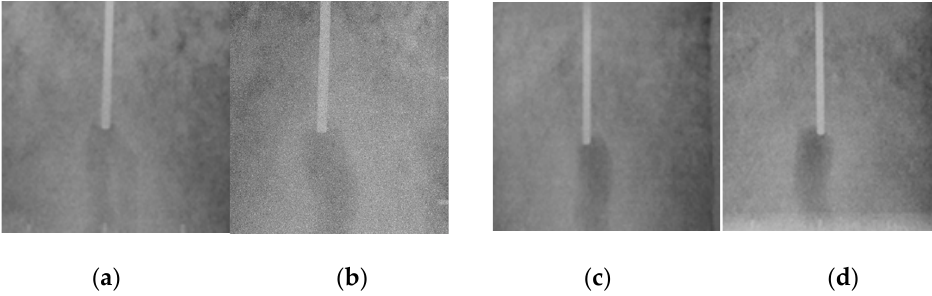
Figure 3. Images of soil with the same resistivity and different water content: ( a ) The moisture is 23.56%; ( b ) moisture is 39.14%; ( c ) moisture is 40.50%; ( d ) moisture is 48.80%.